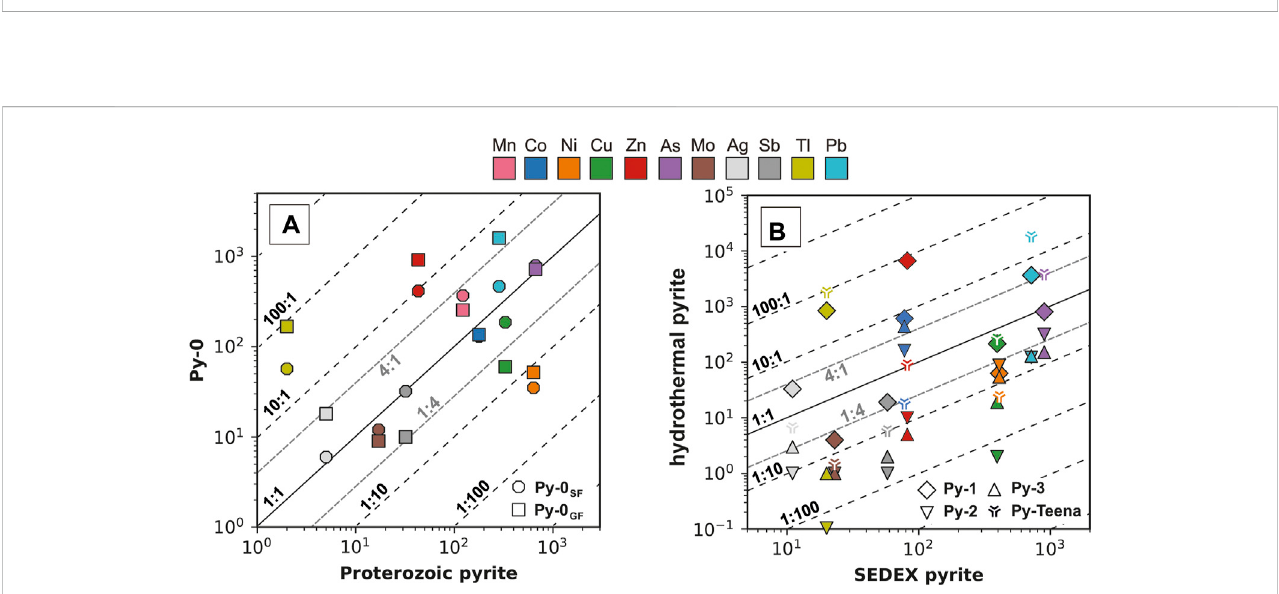
FIGURE 10 (A) Acomparison between median values ofliteraturedata ofsedimentary anddiageneticpyrite from theProterozoic (Large etal.,2014)andPy-0 Py-0 SF . (B) A comparison between median values of literature data for SEDEX hydrothermal pyrite (Gregory et al., 2019), hydrothermal pyrite from the Teena deposit (Magnall et al., 2022), and hydrothermal pyrite from George Fisher (Py-1, Py-2, and Py-3; this